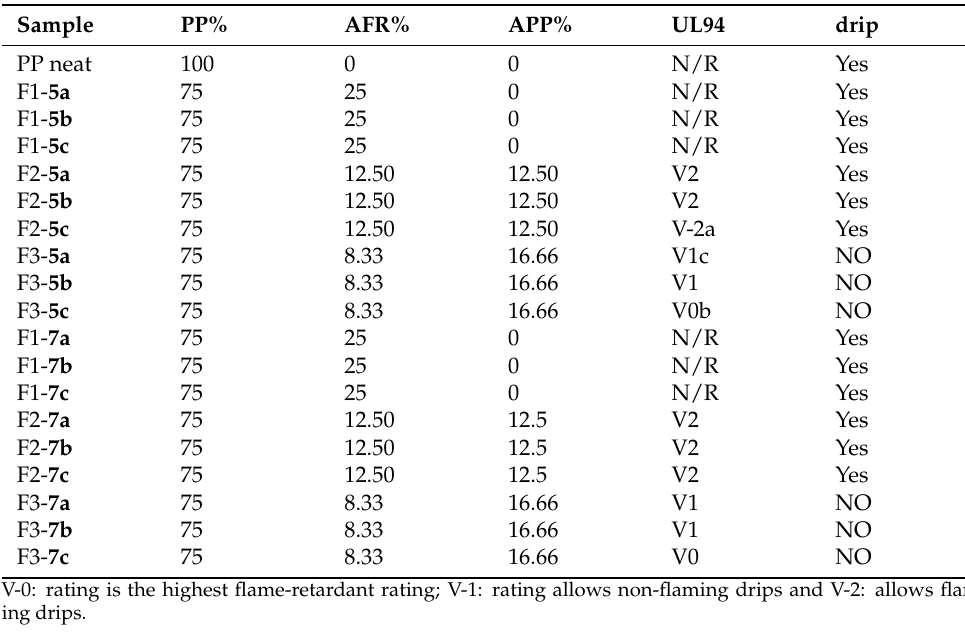
Table 5. Flammability test data of the neat PP and its composites.